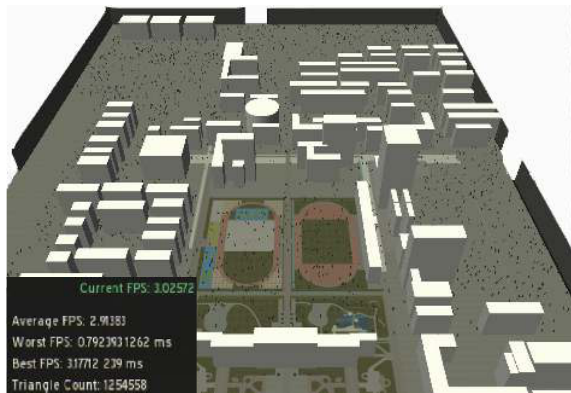
Fig. 7 Overall model and interface of the CESS.